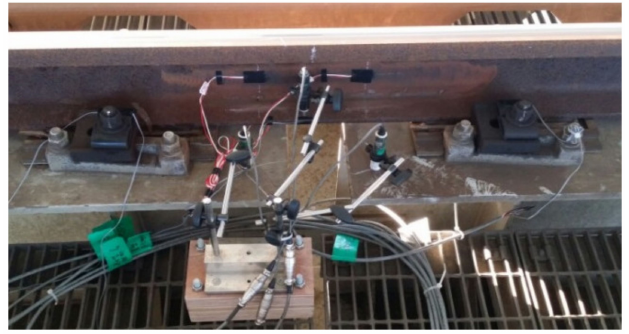
Figure 4. Sensor